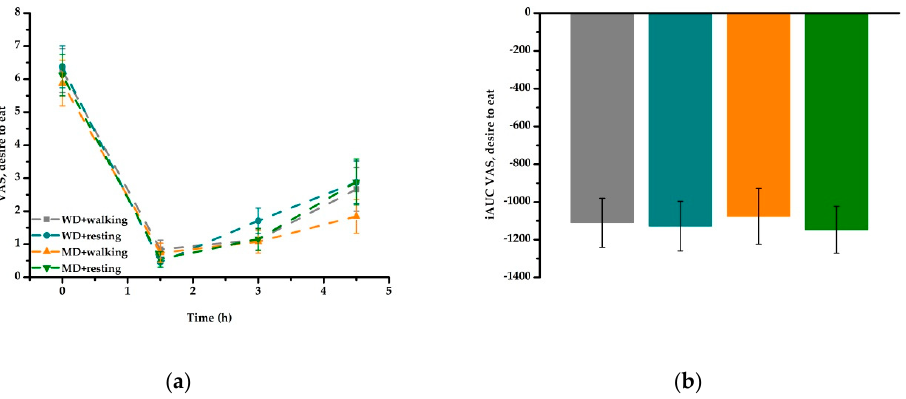
Figure 2. Fasting and postprandial hunger (desire to eat) according to treatment condition: ( a ) the overall sensation of hunger decreased over time ( P < 0.001) in all four treatment conditions. ( b ) iAUC revealed no meal or activity e ff ect. iAUC, incremental area under the curve; MD, Mediterranean-type diet meal; VAS, visual analogue scale; WD, Western diet high-fat meal.